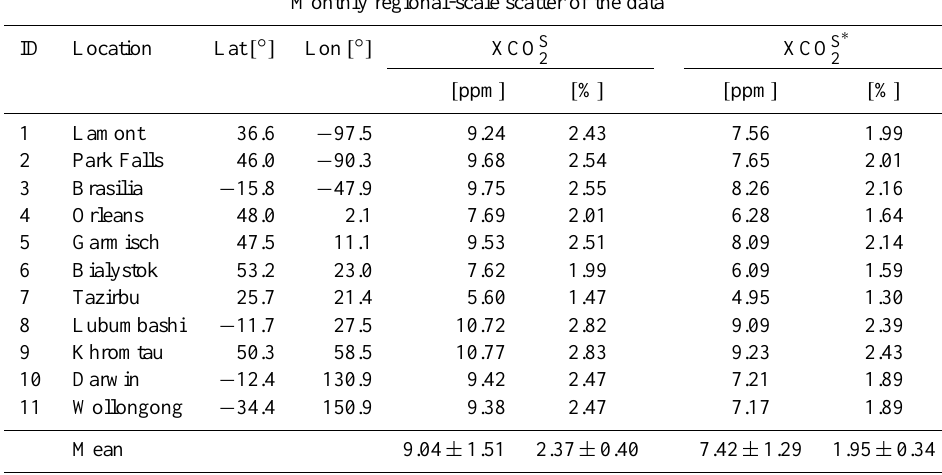
Table 4. Monthly regional-scale scatter (in ppm and %) of the scan-angle-bias corrected (S ∗ ) and uncorrected (S) WFMDv2.1 XCO 2 data obtained from analysing all individual XCO 2 retrievals within a radius of 350km around various locations. The numerical values are the mean standard deviations of all SCIAMACHY retrievals per month (to remove the seasonal